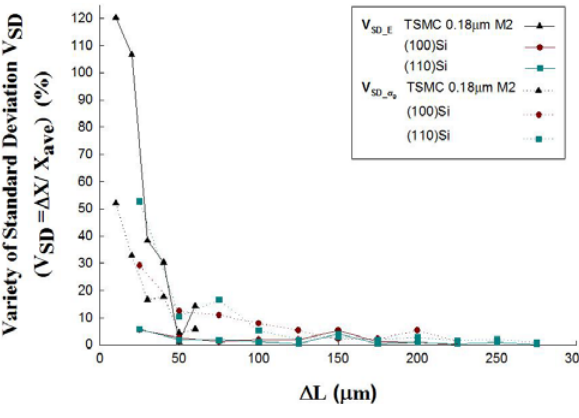
Figure 8. The variation of the extracted values by this